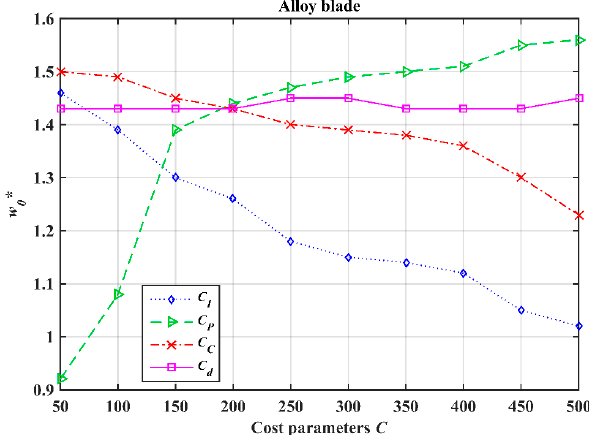
Figure 15. Influence of the cost parameters on the optimal value w ∗ .